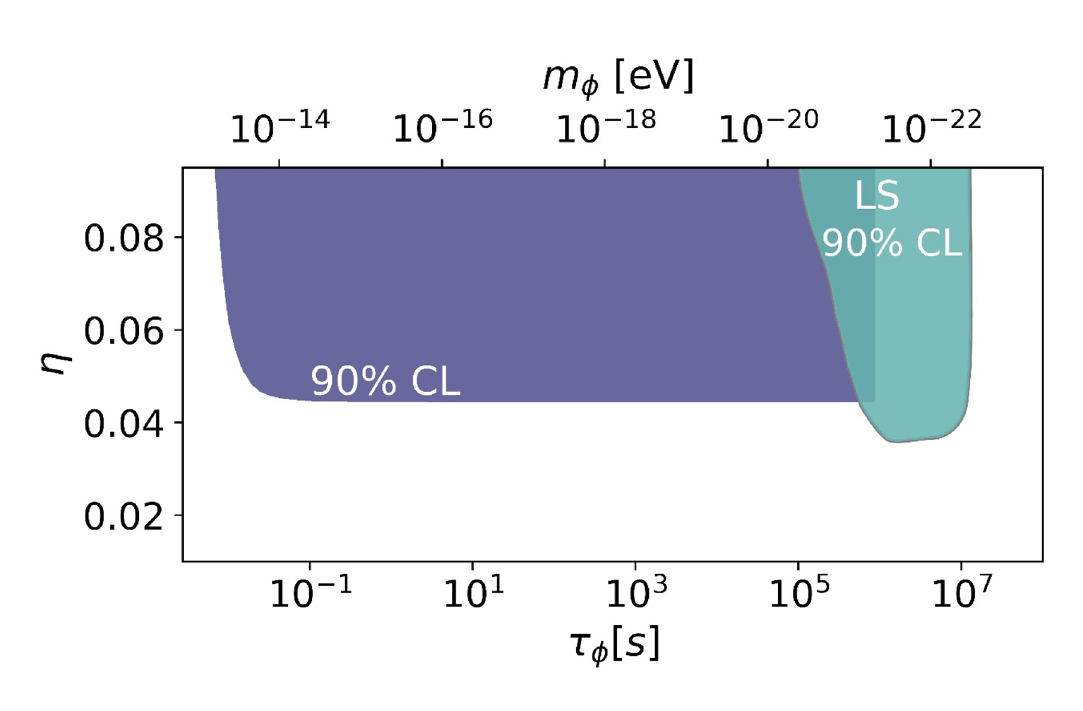
Figure 9 . DUNE sensitivity (90% C.L.) to ultralight scalars via modulation of the atmospheric mass splitting ∆ m 2 . The amplitude of modulation is η (see eqs. (3.1) and (3.2)), and the modu- 31 lation period and mass of the scalar field is denoted by τ φ and m φ ,